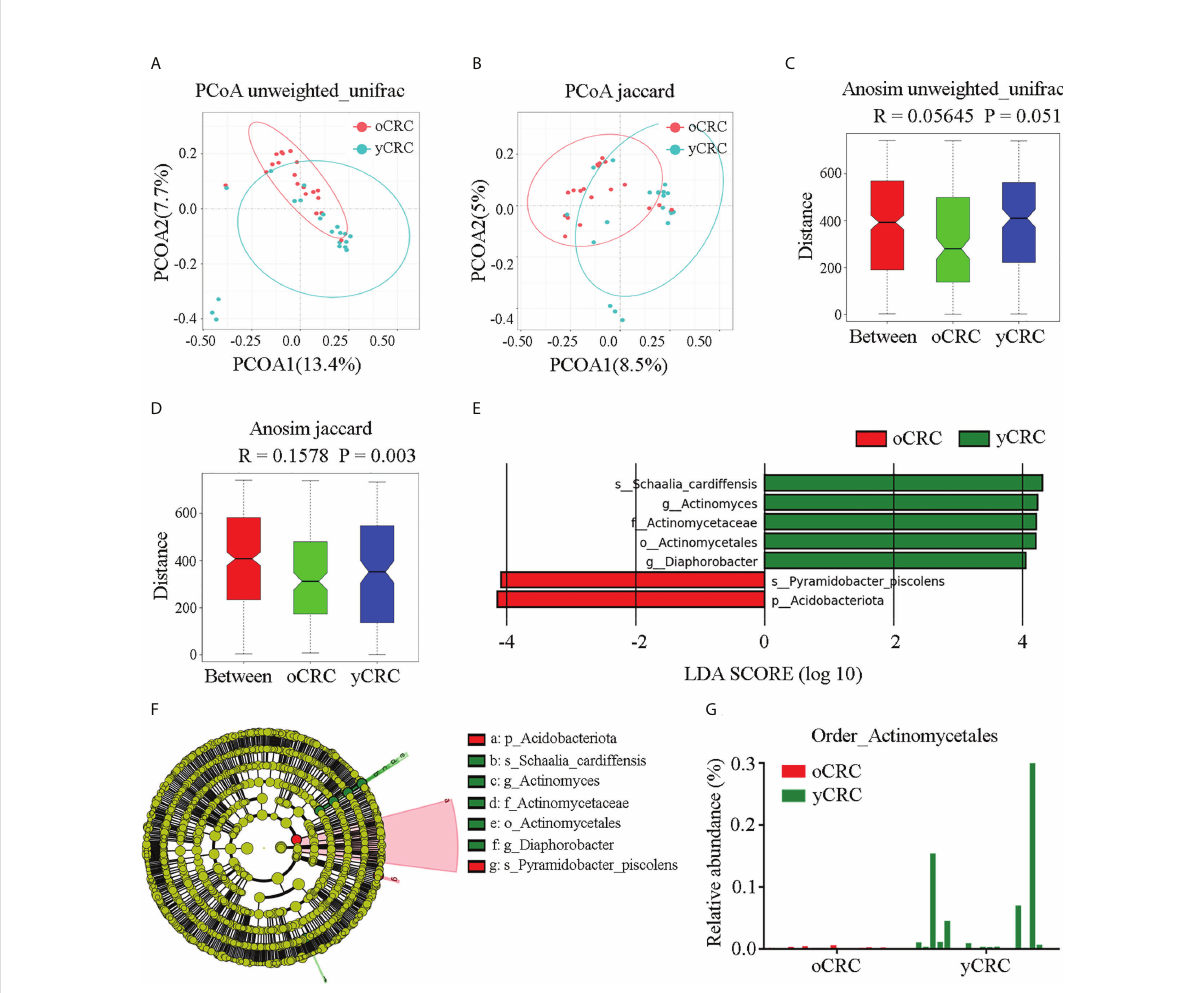
FIGURE 3 Identi fi cation of speci fi c microbial taxa changes in yCRC. (A, C) Beta diversity calculated by principal coordinates analysis (PCoA) of Unweighted UniFrac methods and analysis of similarities (Anosim). (B, D) Beta diversity calculated by PCoA of Jaccard methods and Anosim, indicating a different distribution of microbial community between oCRC and yCRC. (E) The histogram represents linear discriminant analysis (LDA) scores of bacteria with signi fi cant differential abundance between two groups. LDA score>2.0, p<0.05. (F) Taxonomic cladogram represents linear discriminant analysis effect size (LEfSe) analysis for tumor microbiota in two groups. Each node represents a speci fi c taxonomic type. Yellow nodes denote the taxonomic features not signi fi cantly differentiated between two groups. Red nodes denote taxonomic types with more abundance in oCRC group than in the yCRC group; green nodes denote taxonomic types more abundant in the yCRC group than in the oCRC group. (G) Relative abundance of Actinomycetales of each sample at order